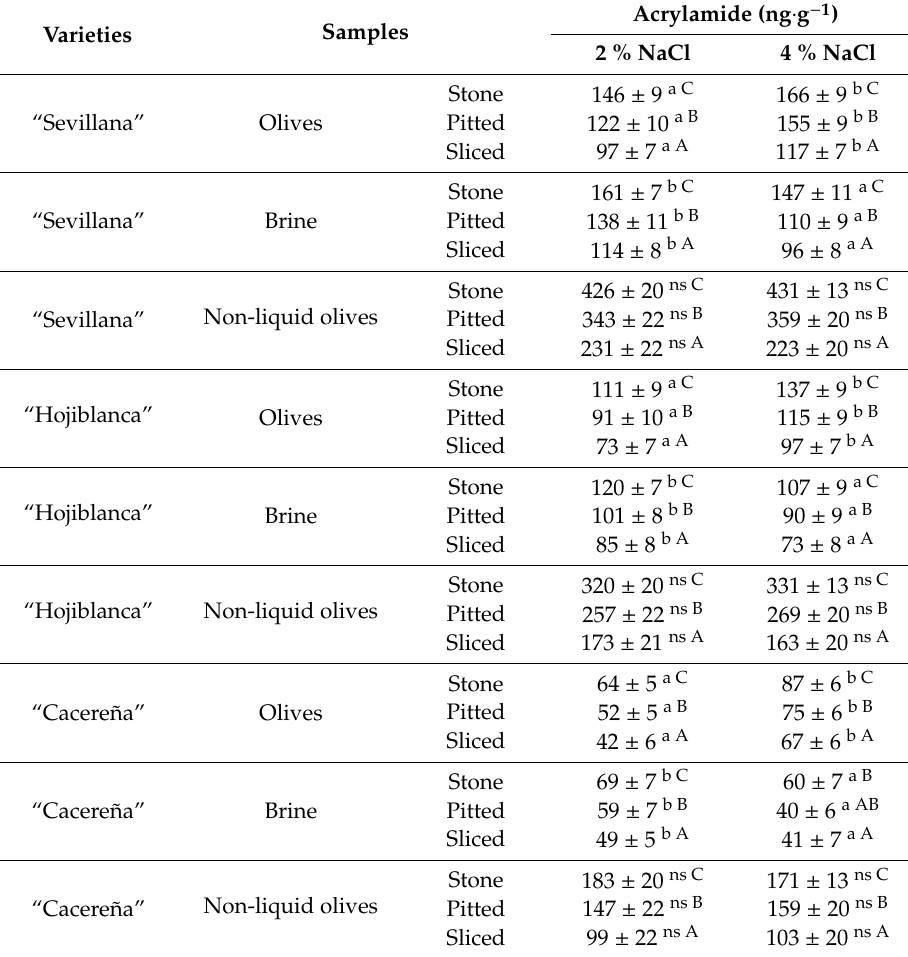
Table 2. Acrylamide content (ng · g − 1 ) of olives and brine after NaCl addition to brine at di ff erent concentrations (2% and 4%) after the sterilization process. Results are expressed as mean ± SD of the five sample replicates. Superscript in the same row indicates statistically significant di ff erences between NaCl treatments (Tukey test, p < 0.05). Di ff erent capital letters in the same columns indicate statistically significant di ff erences between olive presentation formats in each variety (olives, brine, and non-liquid olives) and NaCl